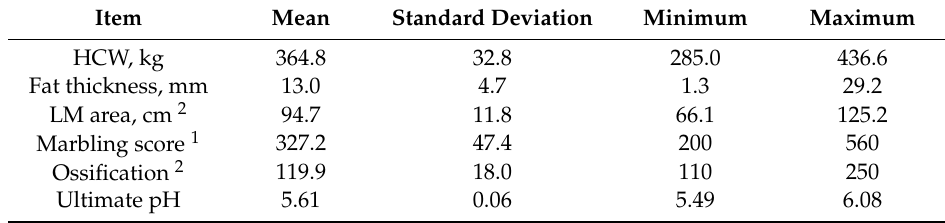
Table 1. Simple Statistics for Carcass Traits of Beef Cattle ( n =